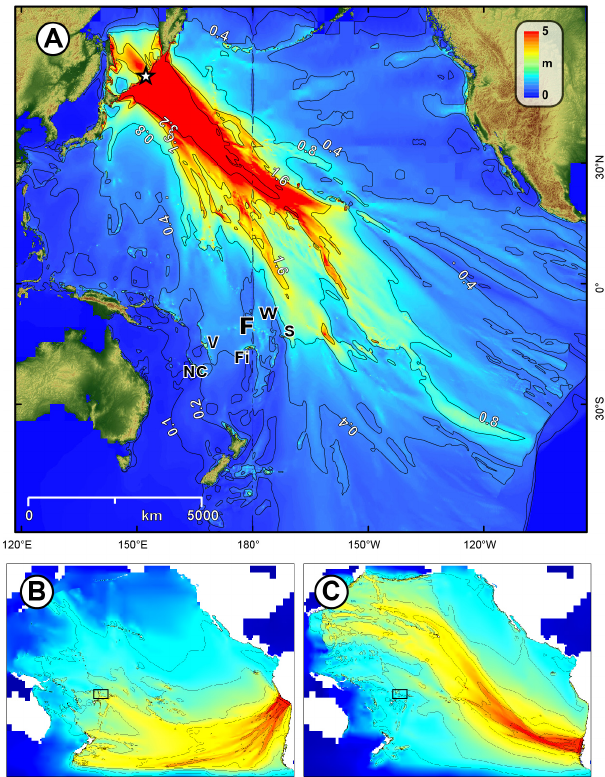
Figure 6. Tsunami maximum wave elevation (MWE in metres), across the Pacific Basin for (a) a M W = 9.1 earthquake source along the Kuril Trench (Sc. 1, Table 4). Star indicates epicentre, F: Futuna, Fi: Fiji; NC: New Caledonia; S: Samoa; V: Vanuatu; W: Wallis; (b) a M W = 9 Peru earthquake (Sc. 5) and (c) a M W = 9.29 Chile earthquake (Sc. 6) Frame is approximate location of W&F. See Ta- ble 4 for source parameters. Models generated using the Gerris flow solver (Popinet,